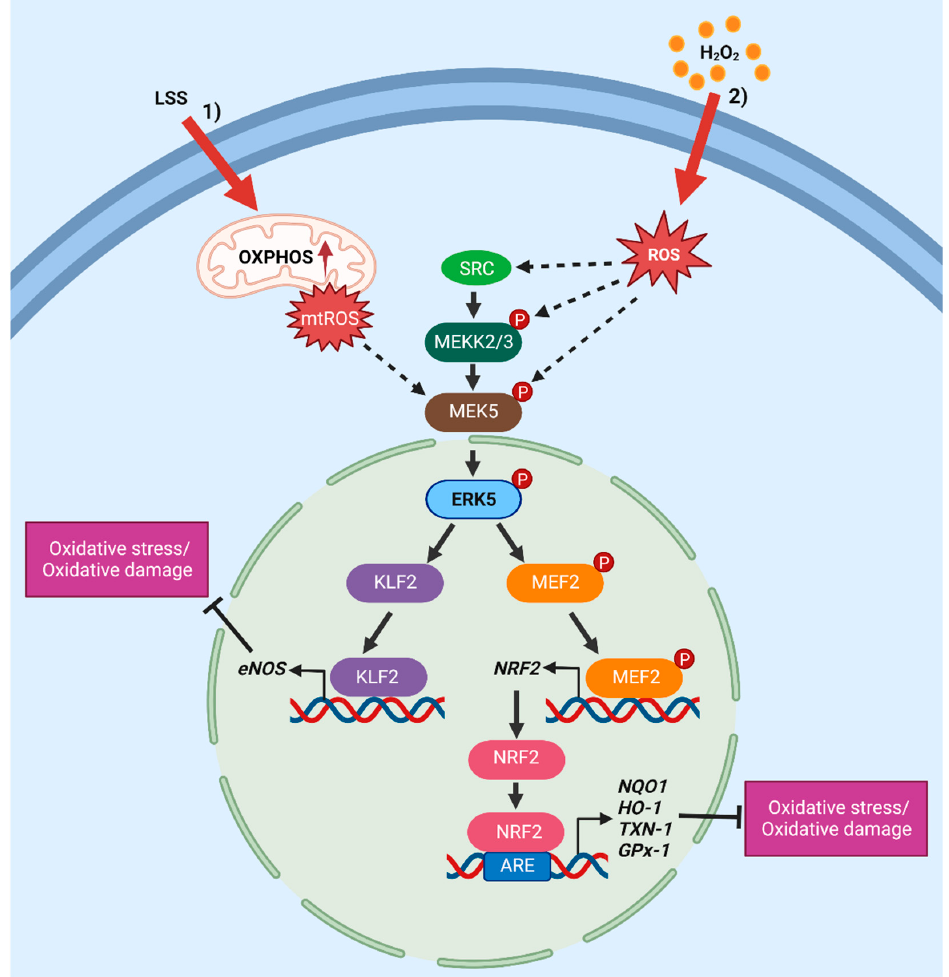
Figure 1. Overview of the mechanisms of activation and downstream effectors of the MEK5/ERK5 pathway in response to oxidative stress. The rising in oxidative stress triggers MEK5/ERK5 activation, which, in turn, promotes an antioxidant response. (1) Laminar shear stress (LSS) induces mtROS production, which, in turn, leads to activation of the MEK5/ERK5/KLF2 pathway [72]. (2) H 2 O 2 stimulation may activate the ERK5 pathway via SRC [36,57,58,62], MEKK2/3 [63] or MEK5 [75,76] activation. Continuous arrows indicate direct activation mechanisms and dashed arrows indicate demonstrated, but not direct, mechanisms. eNOS, endothelial nitric oxide synthase; NQO1, NAD(P)H quinone dehydrogenase 1; HO-1, heme oxygenase-1; TXN-1, thioredoxin-1; GPx-1, glutathione peroxidase (created using Biorender.com accessed on 23 March 2023).